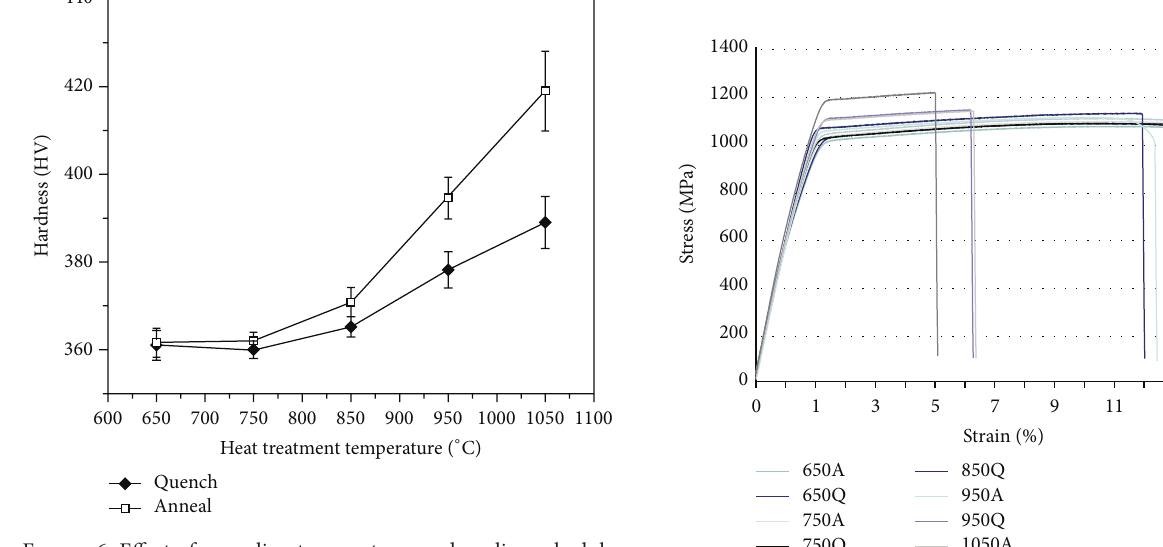
Figure 6: Effect of annealing temperatures and cooling schedules on hardness of Ti6Al4V.